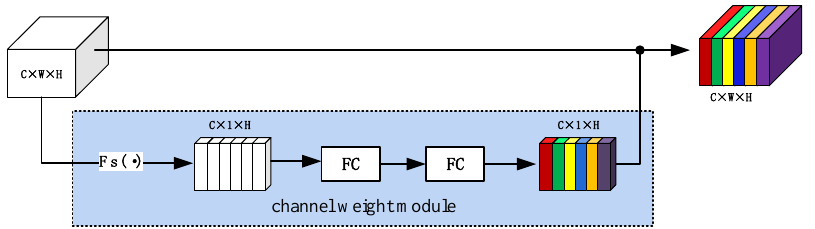
Figure 6. The framework of channel weight module.